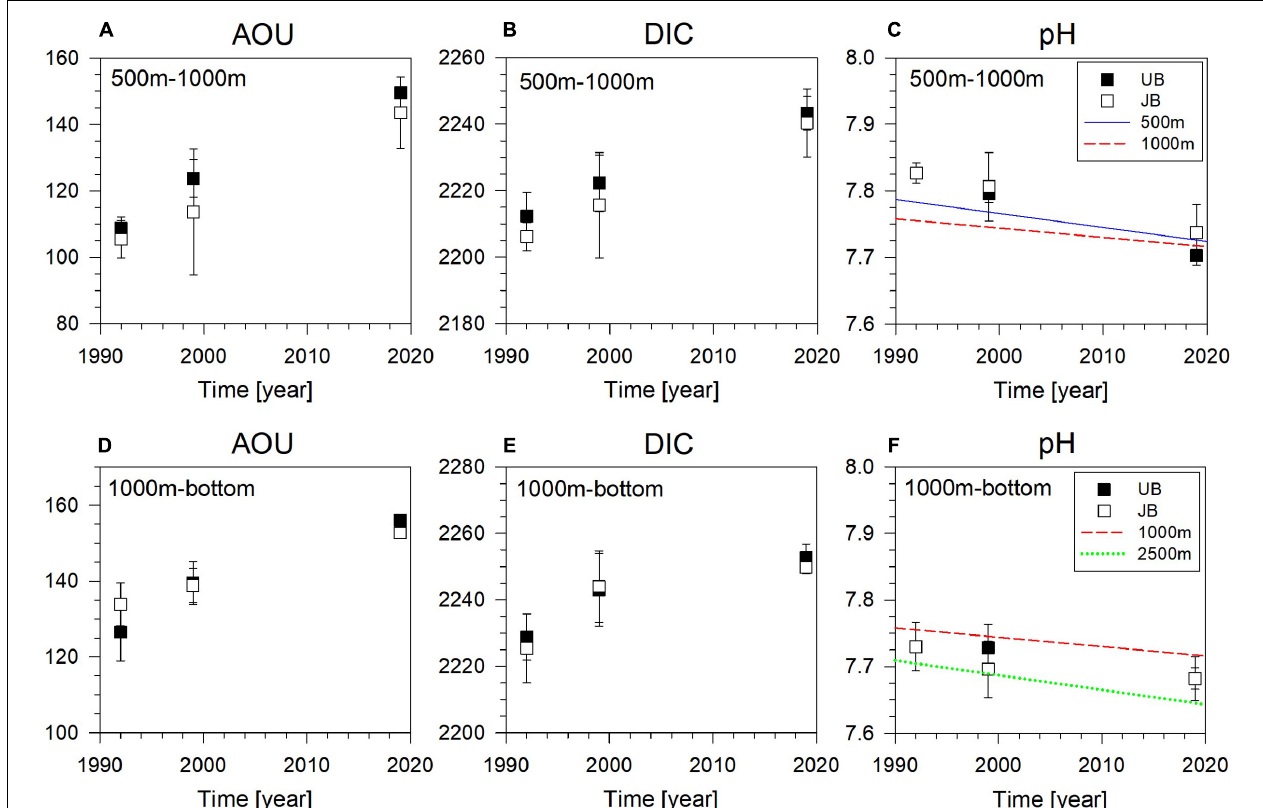
FIGURE 5 | Temporal variations of AOU in µ mol kg − 1 (A,D) , DIC (B,E) in µ mol kg − 1 , and pH on the total hydrogen scale (C,F) in the 500–1,000 m layer (upper panels) and in the 1,000 m – bottom layer (lower panels) in the Ulleung Basin (UB, filled symbols) and the western Japan Basin (JB, open symbols). The error bars represent standard deviation of the data in each depth bin. The mean and standard deviations in the corresponding layer are plotted. Temporal trends for AOU and pH reported in Chen et al. (2017) are also shown for comparison (lines at each depth indicated in the figure